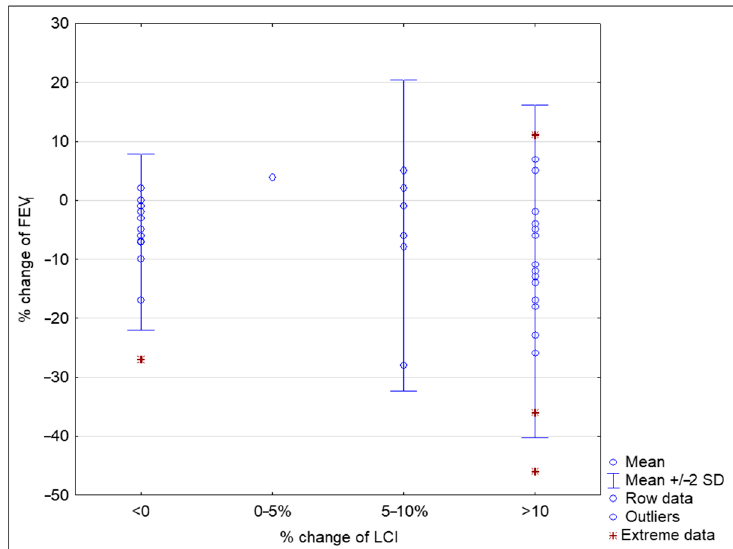
Table 2. Lung clearance index (LCI), forced expiratory volume in 1 s (FEV 1 ), and forced vital capacity (FVC) values during the stable condition, at hospital admission, and after pulmonary exacerbation (PEx) treatment for the study population ( n = 40 patients).